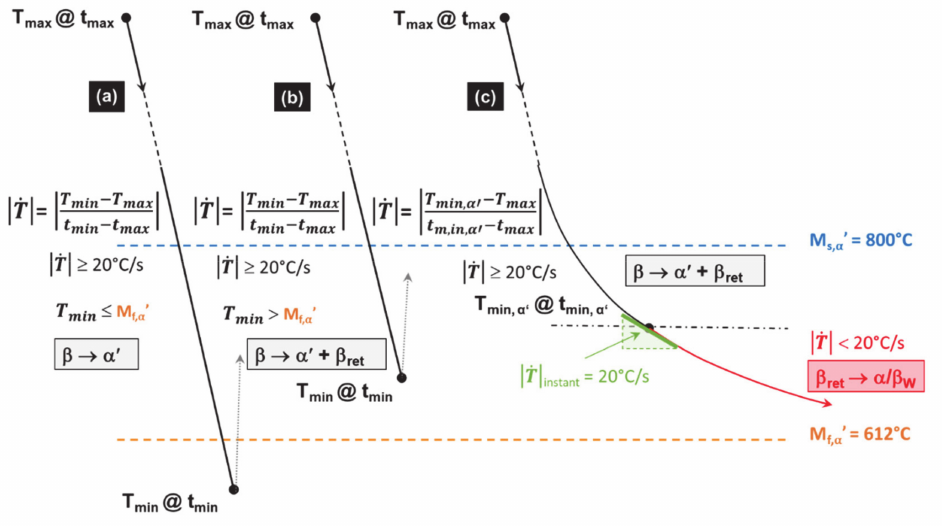
(cid:12) (cid:12) . (cid:12) (cid:12) T (cid:12) in TTB1 and TTB3. Case ( a ) allows a complete martensite (cid:12) ◦ C/s.